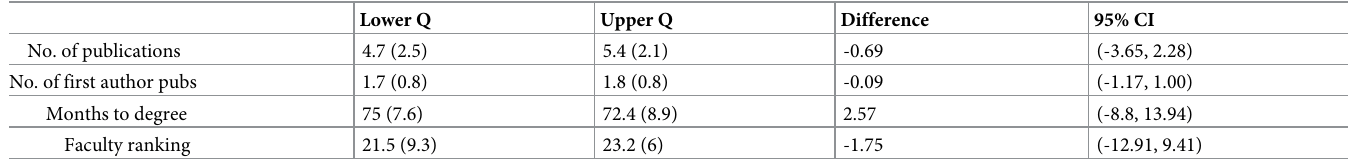
Table 4. Mean (SD) of variables in lower and upper quartiles of GRE-Q and 95% CIs for their difference.